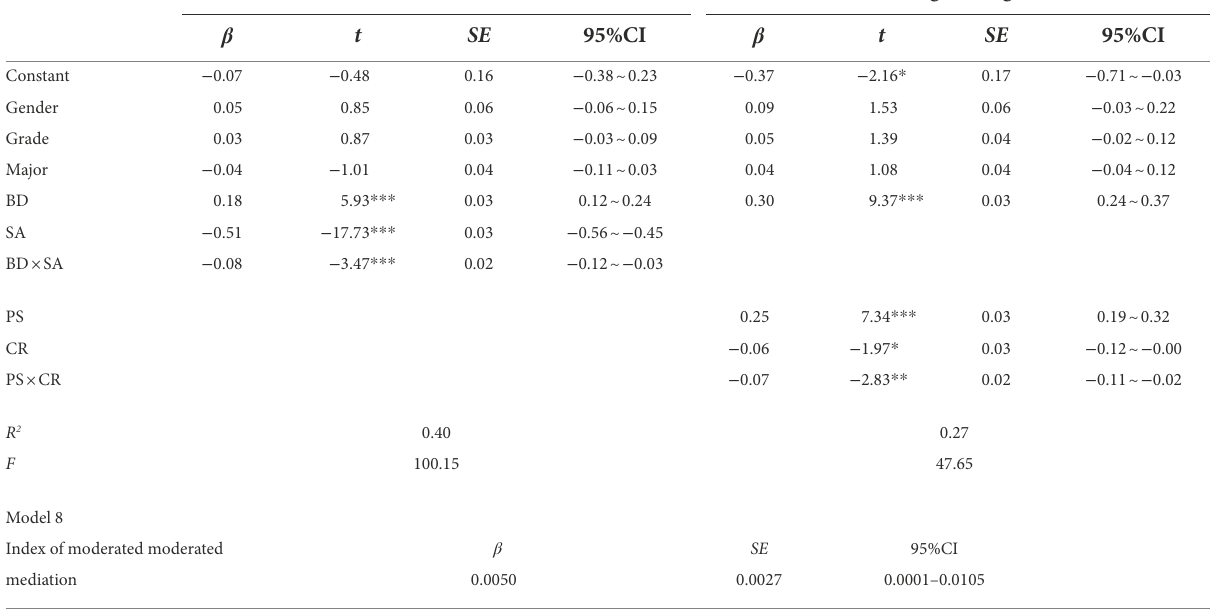
TABLE 4 Testing for the research model.